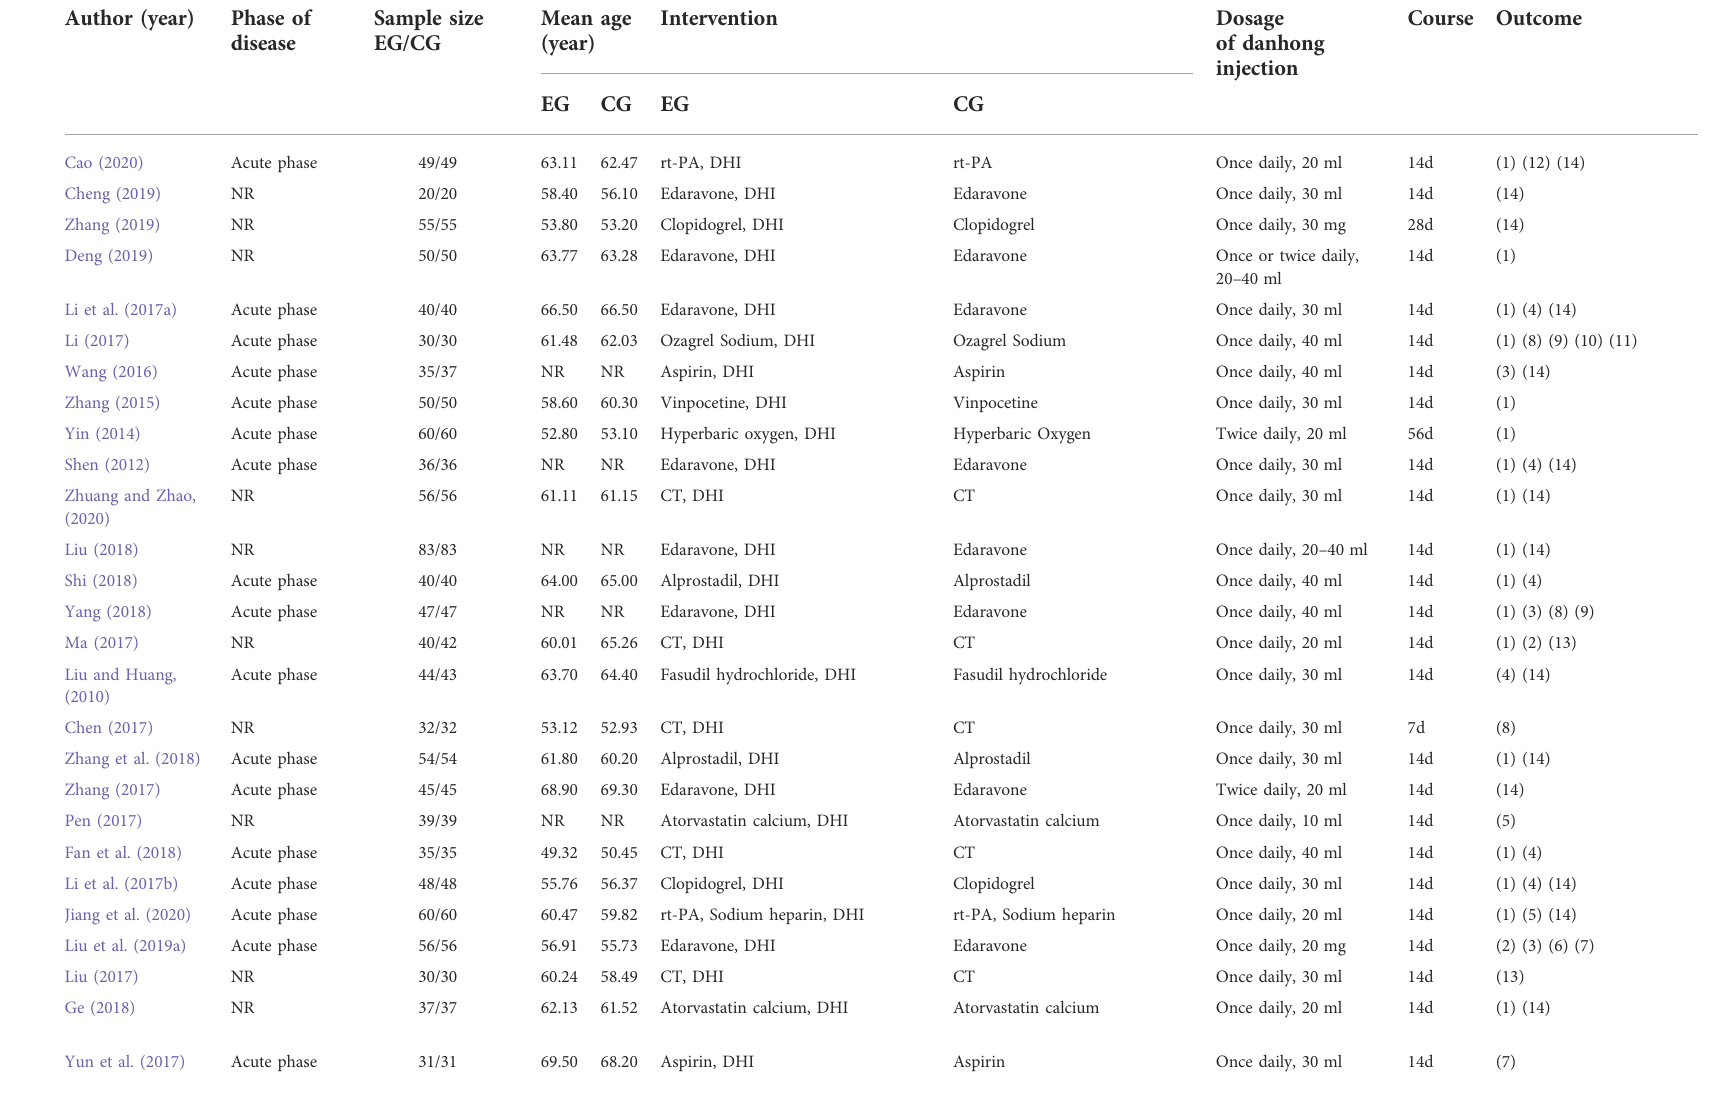
TABLE 1 Baseline characteristics of included randomized controlled